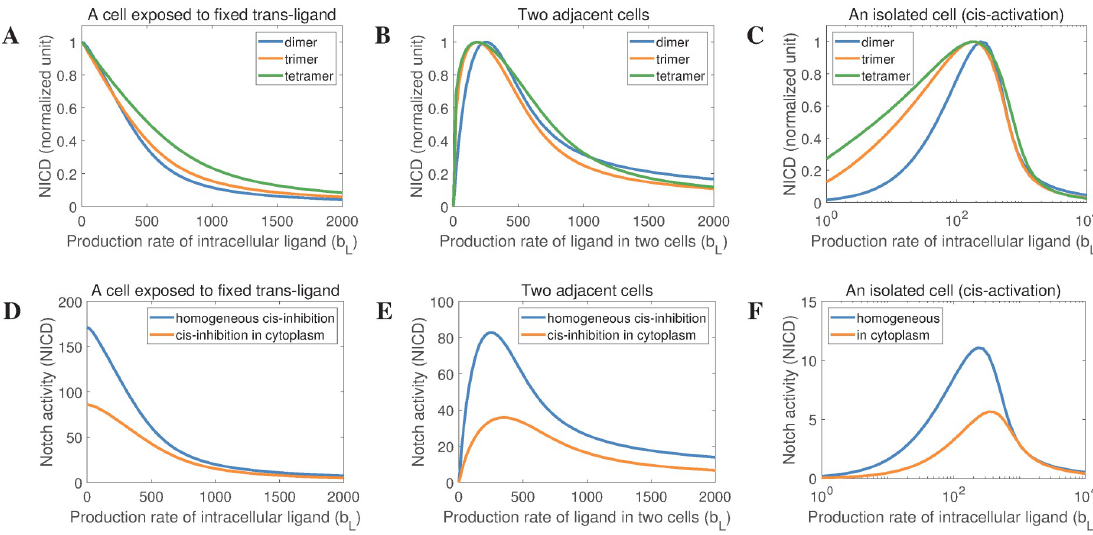
Fig 8. The effect of ligand oligomer size and subcellular localization on cis inhibition of Notch signalling. (A-C) The response of Notch to intracellular ligands of different oligomer size in a cell exposed to fixed levels of trans-ligand (A), in two identical cells (B), and in a single cell (C). Notch activity is normalized against the maximum Notch activity. (D-F) The response of Notch to the production rate of intracellular ligand. Here, we compared simulations of cis inhibition which can occur in all cell compartments (spatially homogeneous), with cis-inhibition occurring only in the